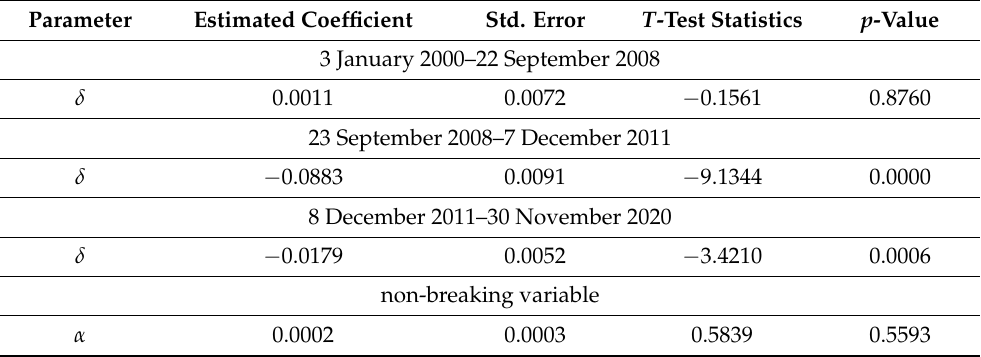
Table 3. Regression model (5) with sequential Bai–Perron test for structural breaks for the S&P GSCI Sugar Index and the VIX